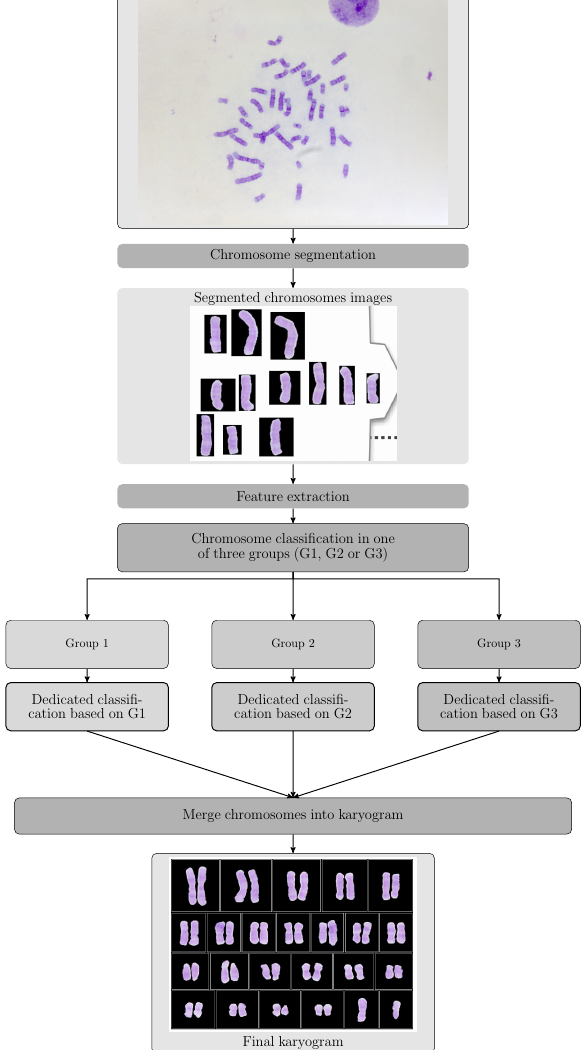
Figure 3. Four step methodology to generated a cytogenetic